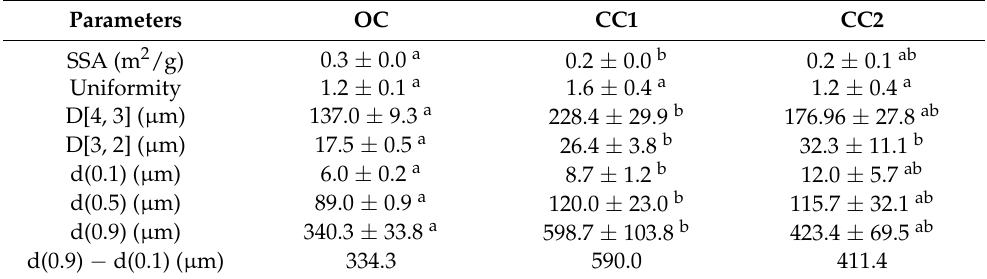
Table 2. Specific surface area (SSA) and particle size distribution of 5% ( w / v , on a protein basis) aqueous reconstituted protein extracts from one organically (OC) and two conventionally (CC1 and CC2) cultivated hempseed samples.